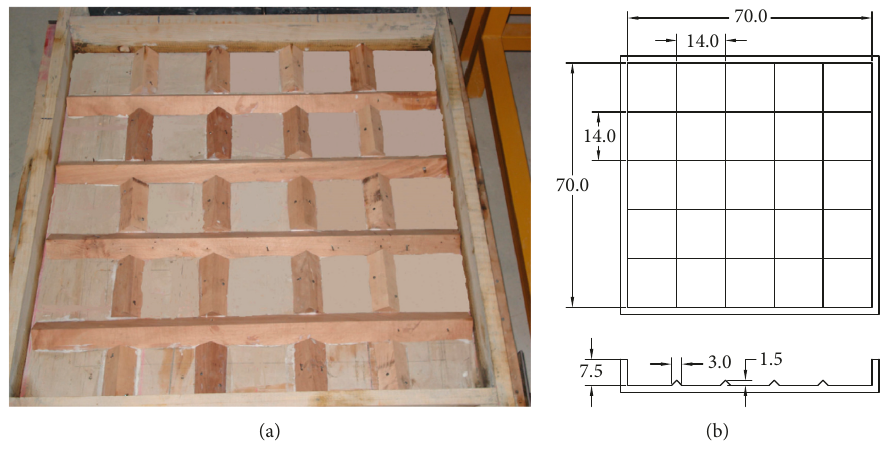
Figure 4: Formwork of restraint plastic